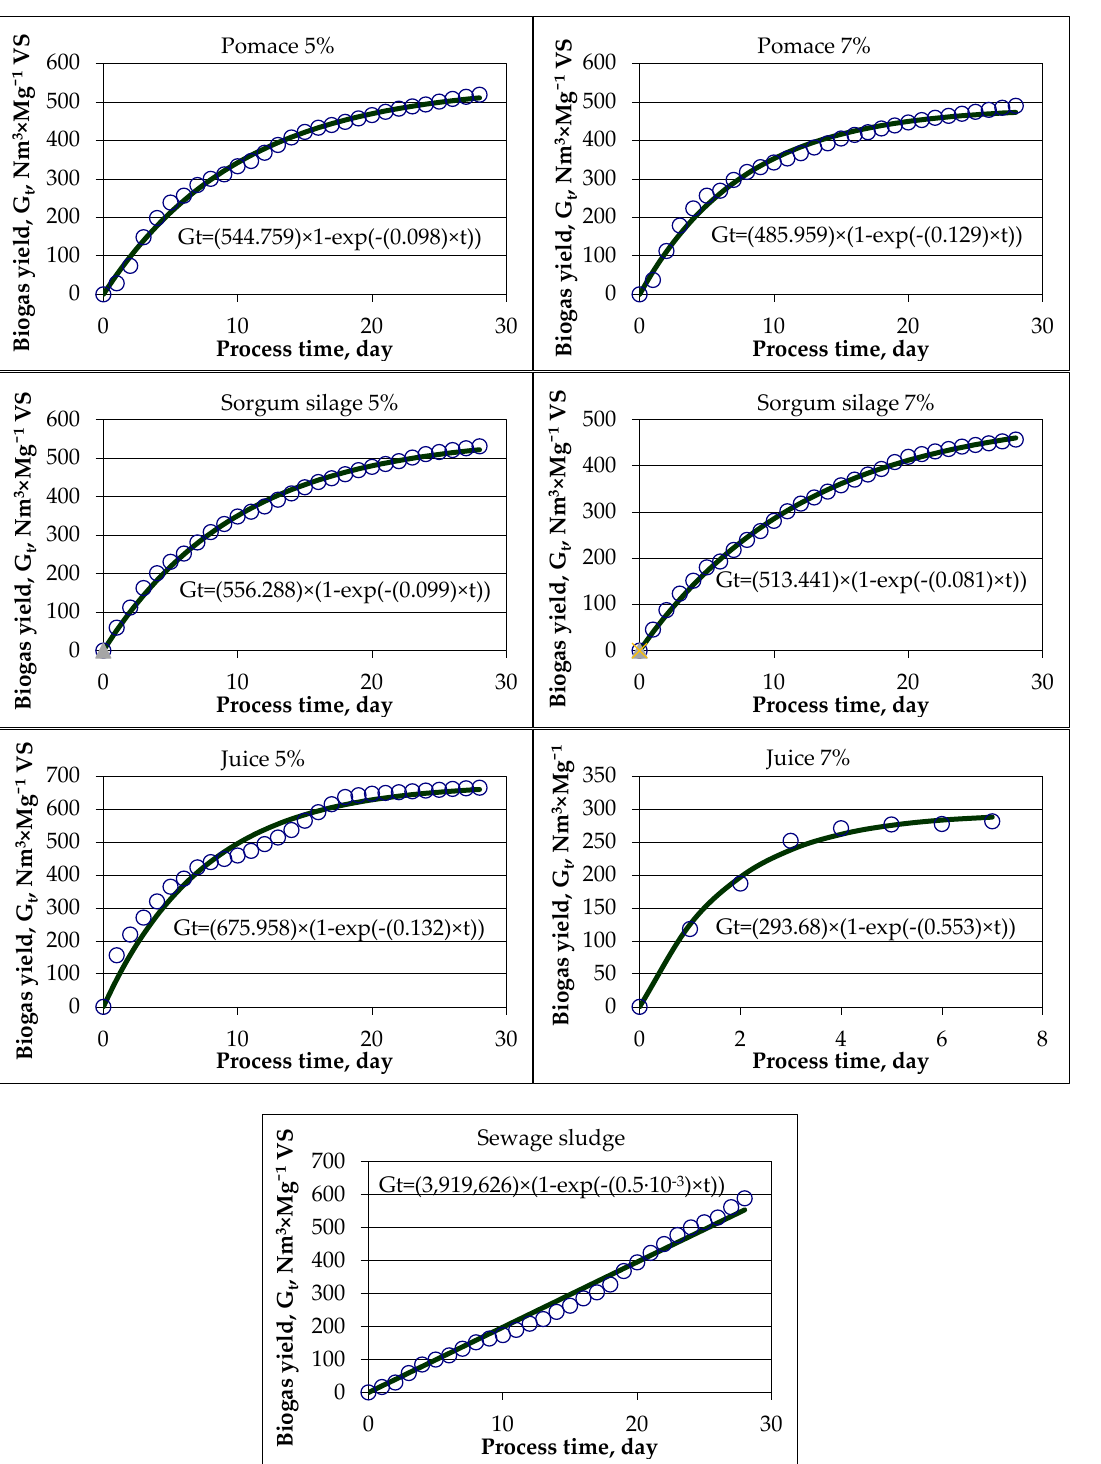
Figure 5. Cumulative biogas production from sewage sludge and substrates from sorghum in the Tabasarana model.